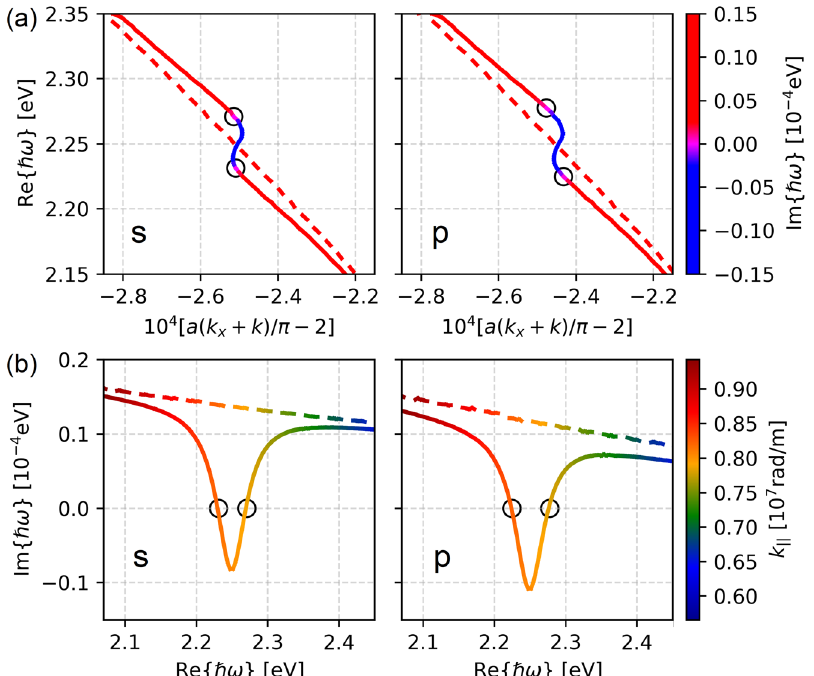
Figure 10: Results of the complex eigenfrequency analysis using finite element method (COMSOL) for periodic metasurfaceofgainmediumnanoparticles – the same as in Sections 2.2 and 2.3: trajectories of the complex-valued eigen- frequencies as a function of k x , correspond- ing to the TE (s-polarized/in-plane-oriented dipoles)andTMguidedmodes(p-polarized/ out-of-plane-oriented dipoles). Solid con- tours: g max = 300 cm − 1 , dashed